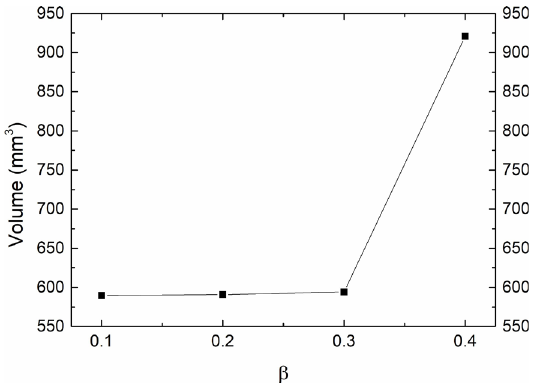
Figure 3. Volume evolution of pellet samples as a function of β.